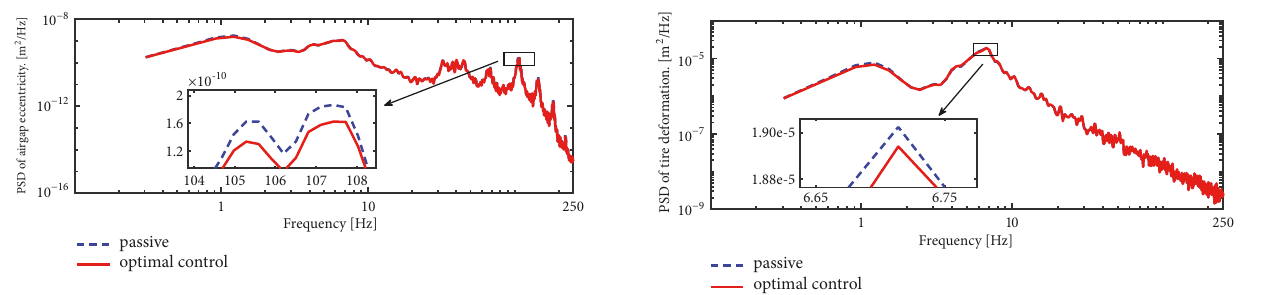
Figure 12: Frequency response of airgap eccentricity.